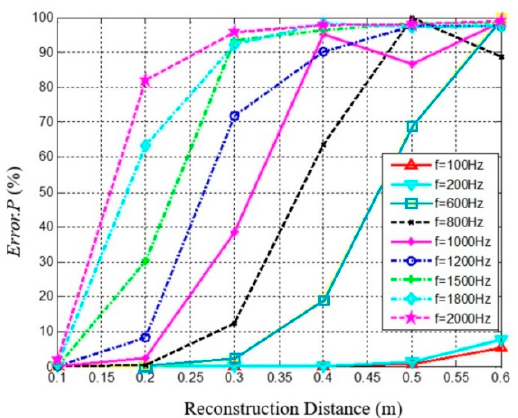
Figure 3. The reconstruction errors vary with reconstruction distance at different sound frequen- cies (spherical radius r = 0.1